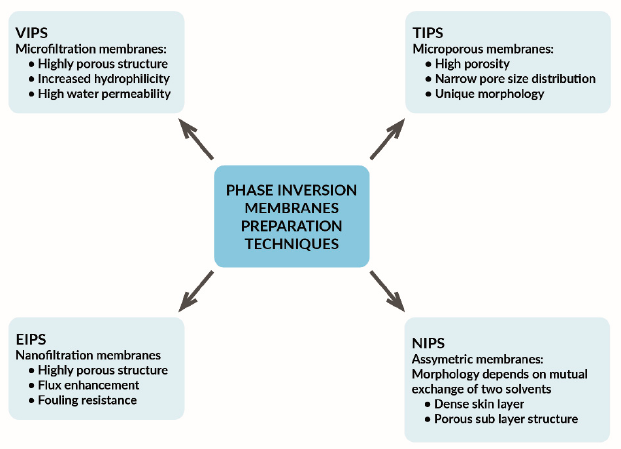
Figure 1. The effects of applied phase inversion techniques on the membrane properties.